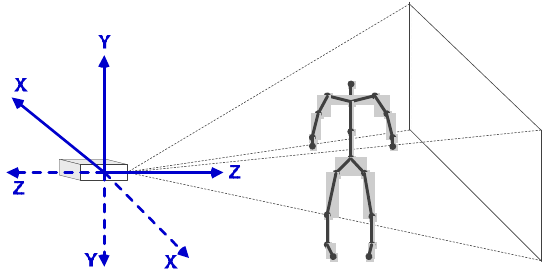
Figure 5. The 3D coordinate system of Kinect camera